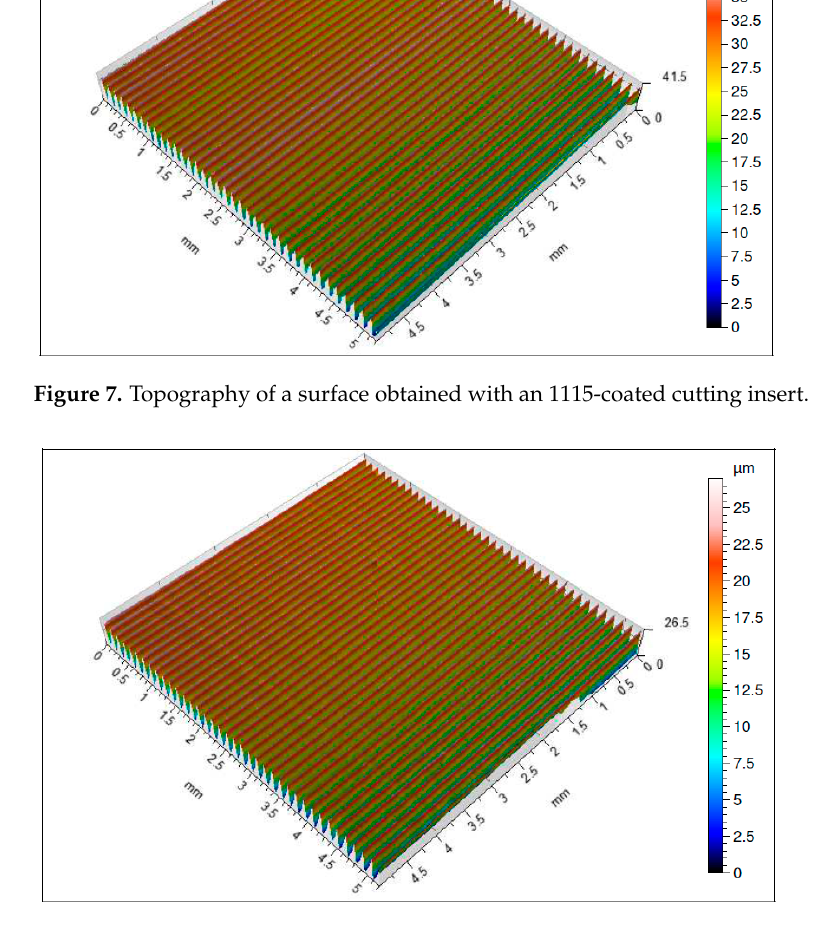
Figure 8. Topography of a surface obtained with an S05F-coated cutting insert.